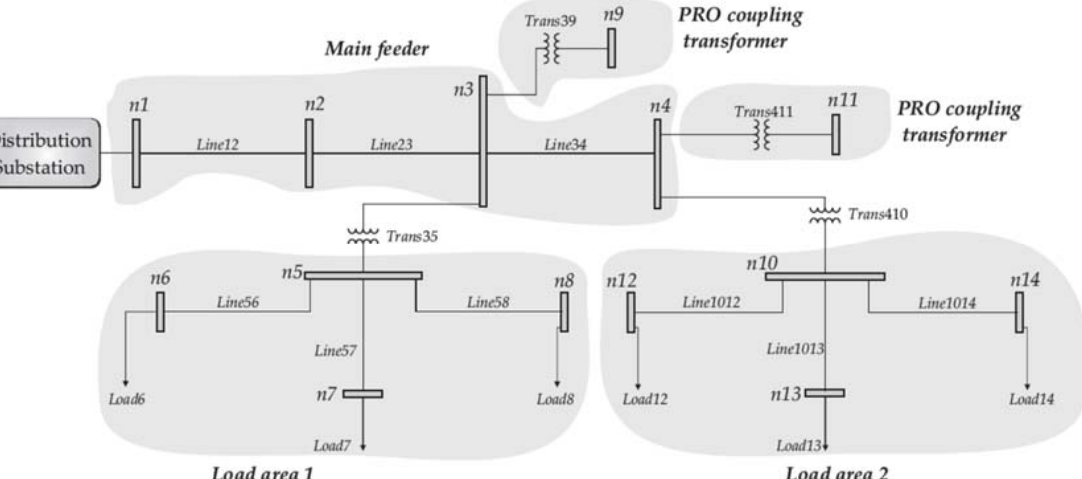
Figure 10. General structure of the test system.